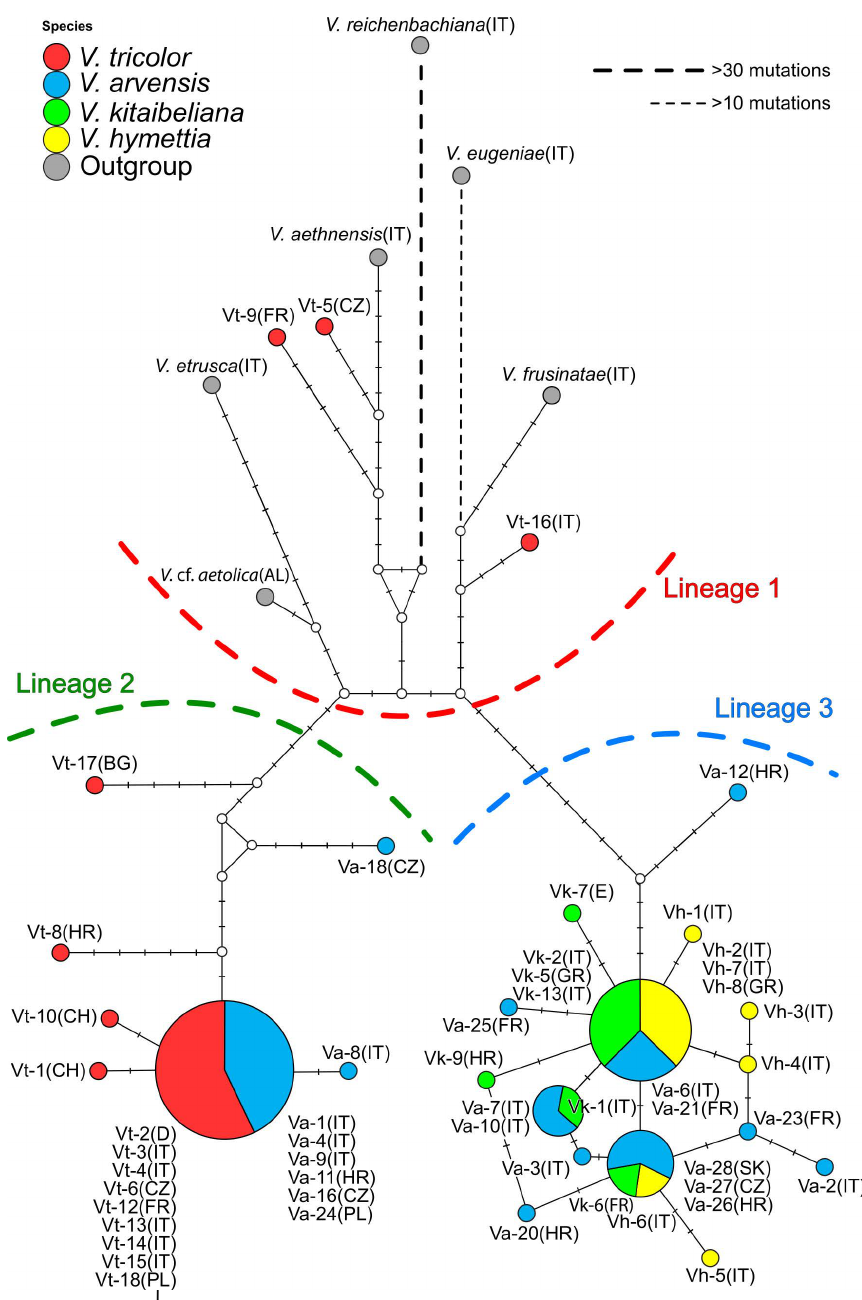
Figure 1. Median Joining haplotype network of the trnH-psbA + rps19-trnH + trnD-trnY concatenated regions in the investigated dataset. Colors identify the different species and the ecological features of each sample are reported (detailed in Supplementary File S1). Line shape and thickness indicate the relative number of mutations separating each haplotype. L1–L3 = inferred haplotype